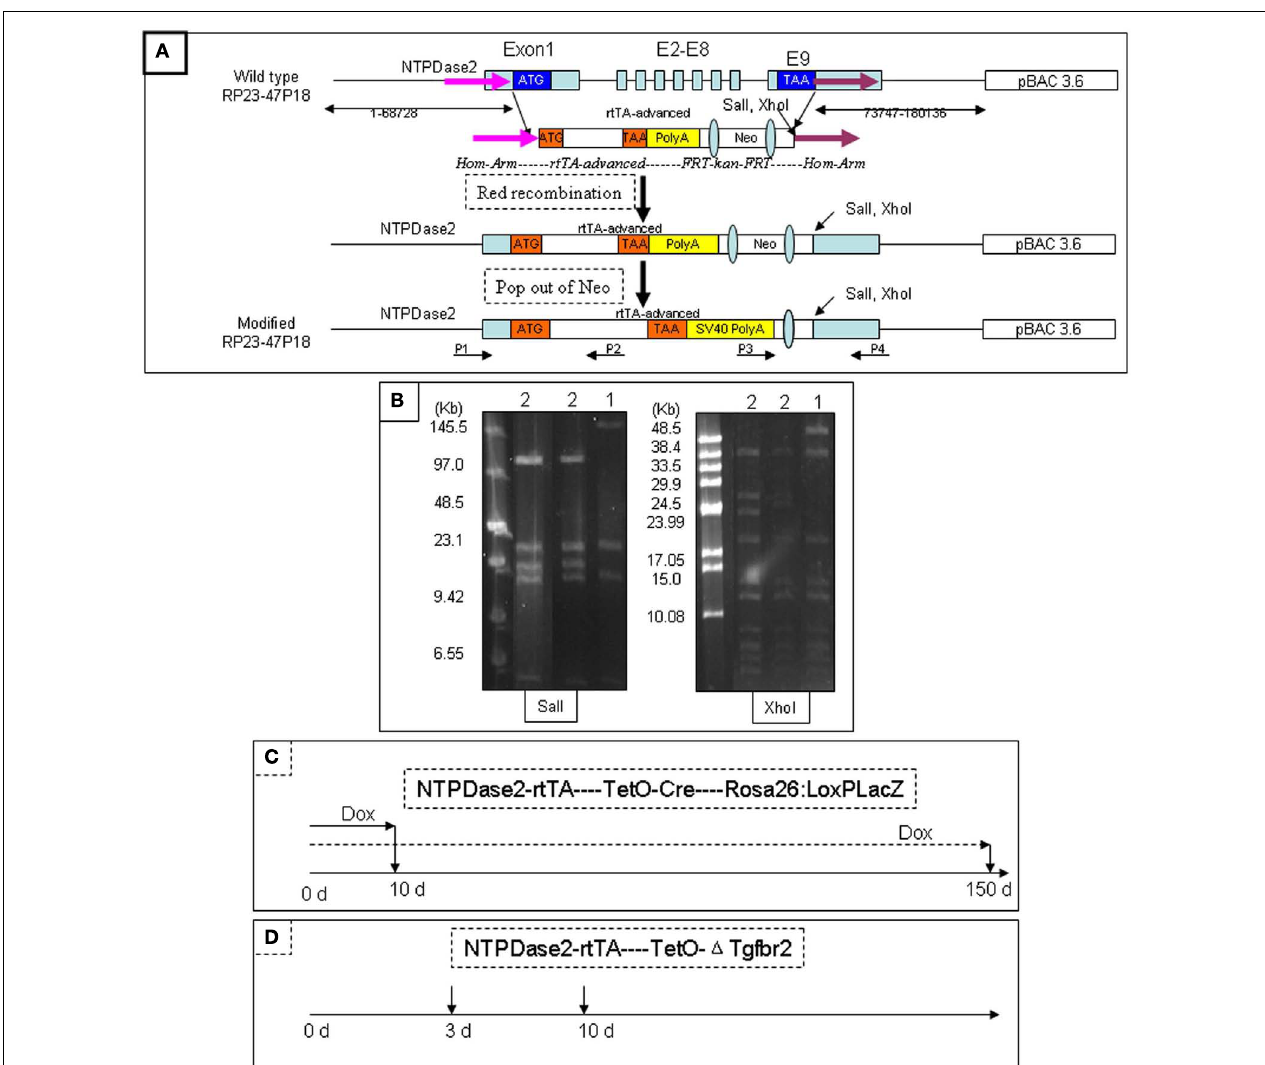
was cut into two pieces, 27 and 28kb in the modified BAC DNA. (1) Original BAC DNA, RP23-47P18. (2) Modified BAC DNA. (B) The triple-transgenic mice (NTPDase2-rtTA-TetO-Cre-Rosa26: LoxPLacZ) were continually induced with Dox for 10 or 150days. (C) The PTR transgenic mice contain the